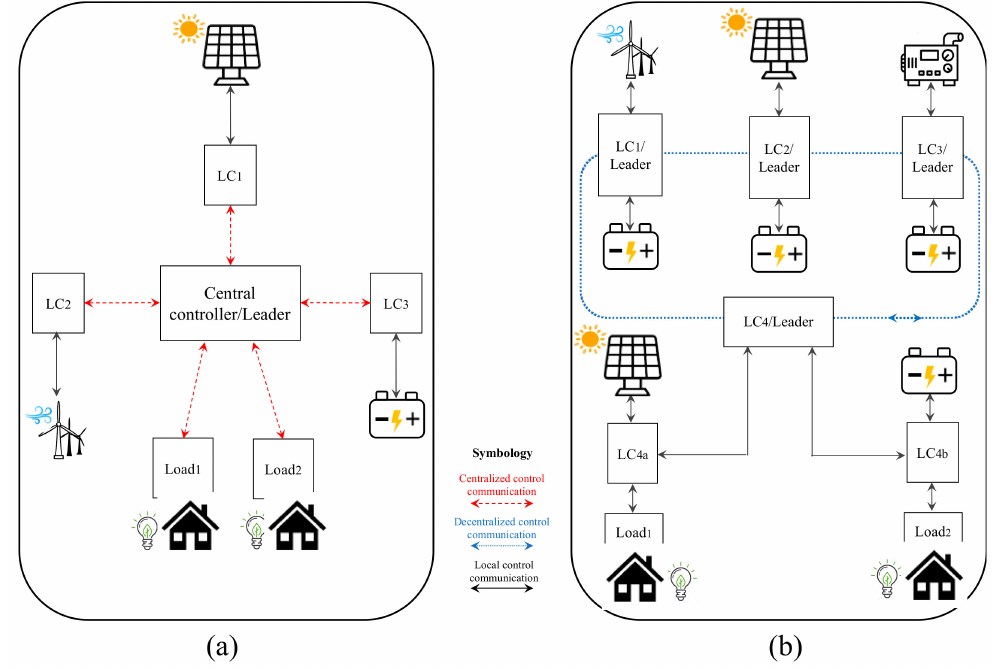
Figure 1. ( a ) Centralized control architecture, ( b ) Decentralized control